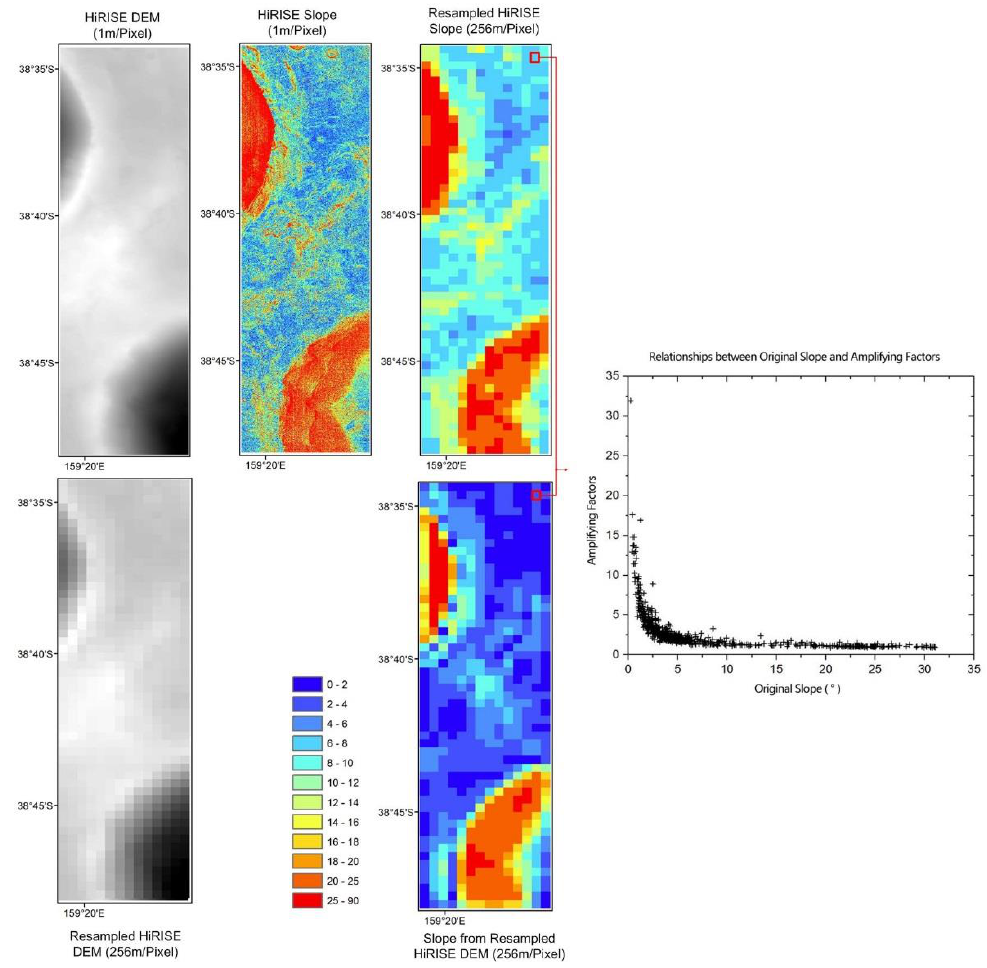
Figure 4. Example to illustrate the process of slope comprision